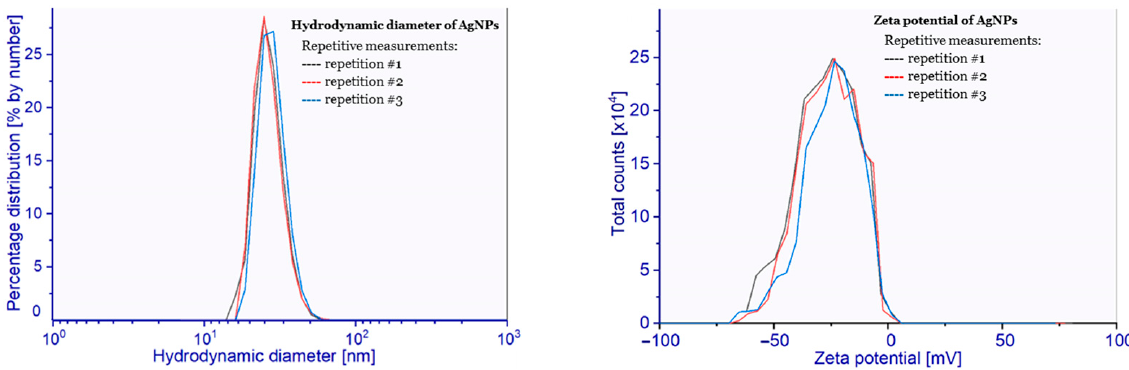
Figure 1. (Left) Hydrodynamic diameter distribution and (Right) surface zeta potential of AgNPs Figure 1. ( Left ) Hydrodynamic diameter distribution and ( Right ) surface zeta potential of AgNPs (the different colors correspond to repeated measurements). (the different colors correspond to repeated